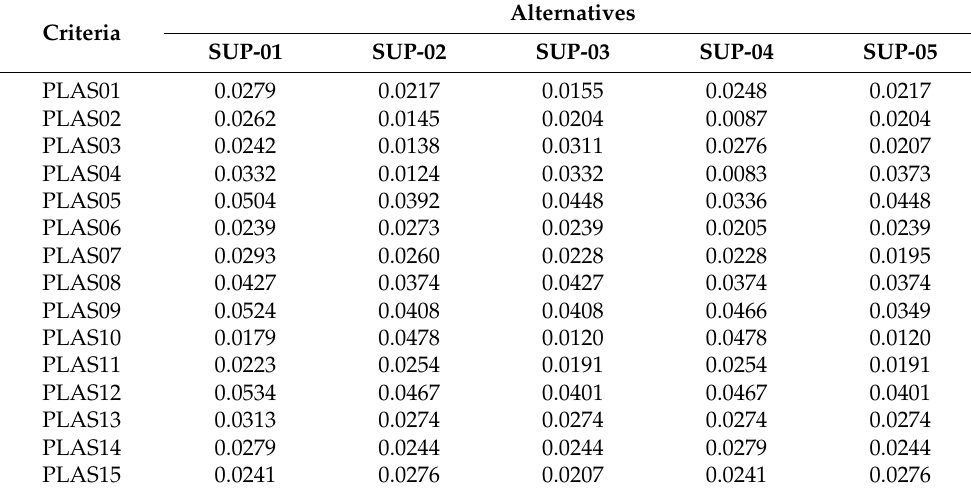
Table 4. Normalized weighted matrix.